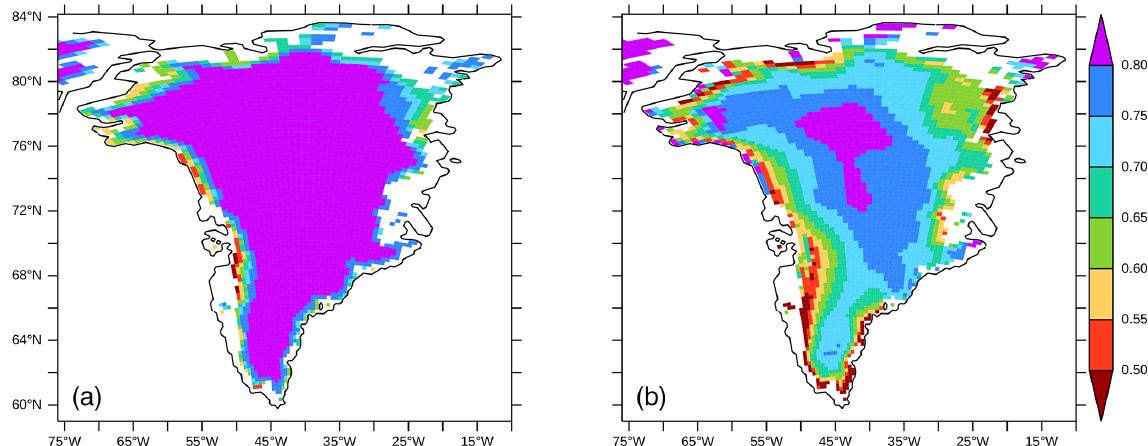
Figure 4. June–July–August average albedo for the surface of Greenland in (a) MAR (minimum 0.48; maximum 0.83) (Fettweis et al., 2013) and (b) FAMOUS-ice (minimum 0.23; maximum 0.78) forced by the MIROC5 climate (1980–1999). To visualise the distribution on sub-grid-scale tiles, FAMOUS-ice results have been trilinearly mapped to the same topography as used in MAR.